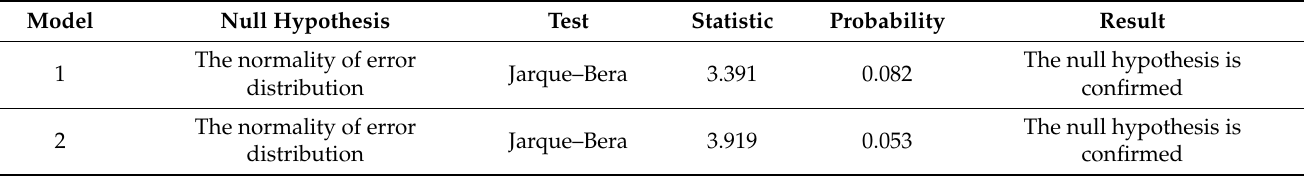
Table 4. The conducted Jarque–Bera test for establishing the random effects model against the fixed effect